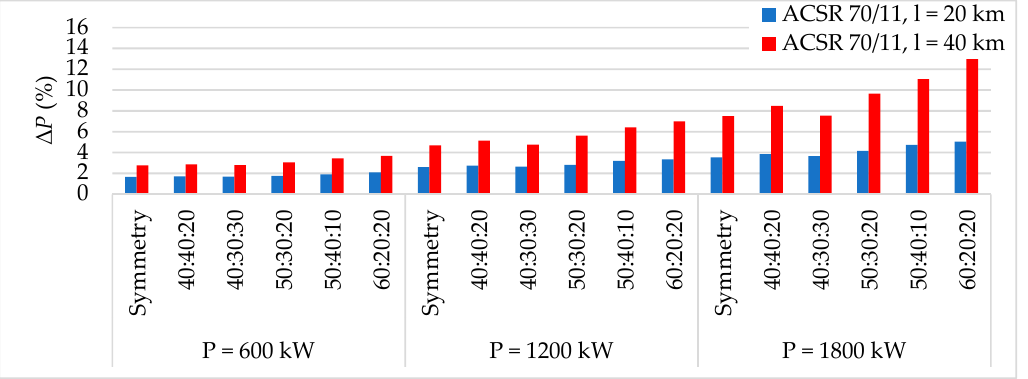
Figure 22. The comparison of the APLs for three types of active powers for conductor ACSR 70/11. Energies 2019 , 12 , x FOR PEER REVIEW